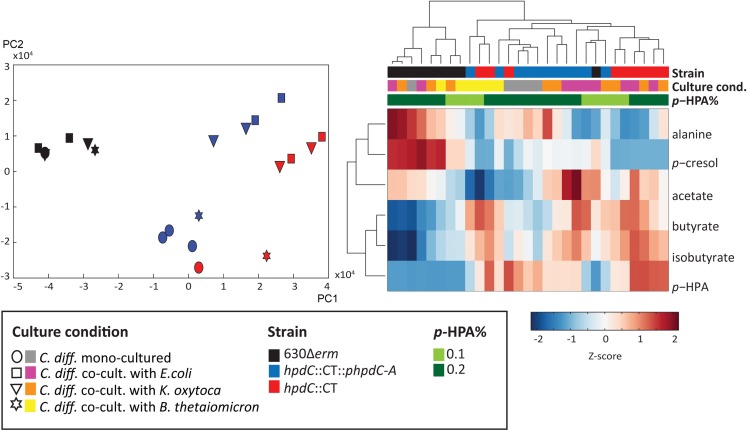
Metabolic profiling of C. difficile in monoculture and competitive co-culture with intestinal commensal species.a) Principle component analysis (PCA) score plot based on the 1H NMR spectra of the three C. difficile strains (630Δerm (black), hpdC::CT (red) and the complemented mutant (hpdC::CT::phpdC-A) in (blue), grown in monoculture (circle symbol) or in competitive co-culture with intestinal commensal species, E. coli (square), K. oxytoca (triangle) and B. thetaiotaomicron (star), in BHIS media supplemented with 0.2% p-HPA. b) Metabolite clustergram represented as a heatmap of Z-scores of the 1H NMR peak integrals, derived from the quantity of six main metabolites driving the separation between the samples (observed on the loading plots of the model) and a dendrogram showing the hierarchical clustering of the samples. The culture conditions, bacterial strains and p-HPA concentration are colour coded in a key on the heatmap.